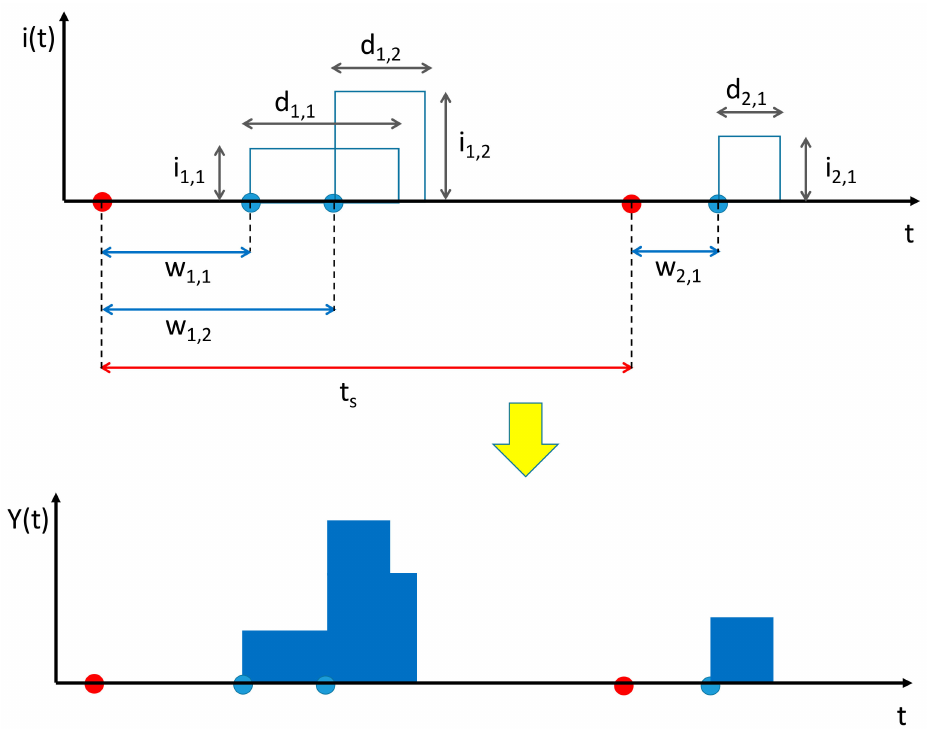
Figure 2. Representation of the Neyman–Scott Rectangular Pulses (NSRP) stochastic process for at-site rainfall modeling. In the upper part of the Figure, 2 storm occurrences (red dots) with an inter-arrival t s , 2 bursts for the first storm and 1 burst for the second storm, are represented. The corresponding waiting times, intensities and duration are also indicated. Then, in the lower part of the Figure, the total precipitation intensity at time t can be calculated as the sum of all the intensities from the active bursts at time t